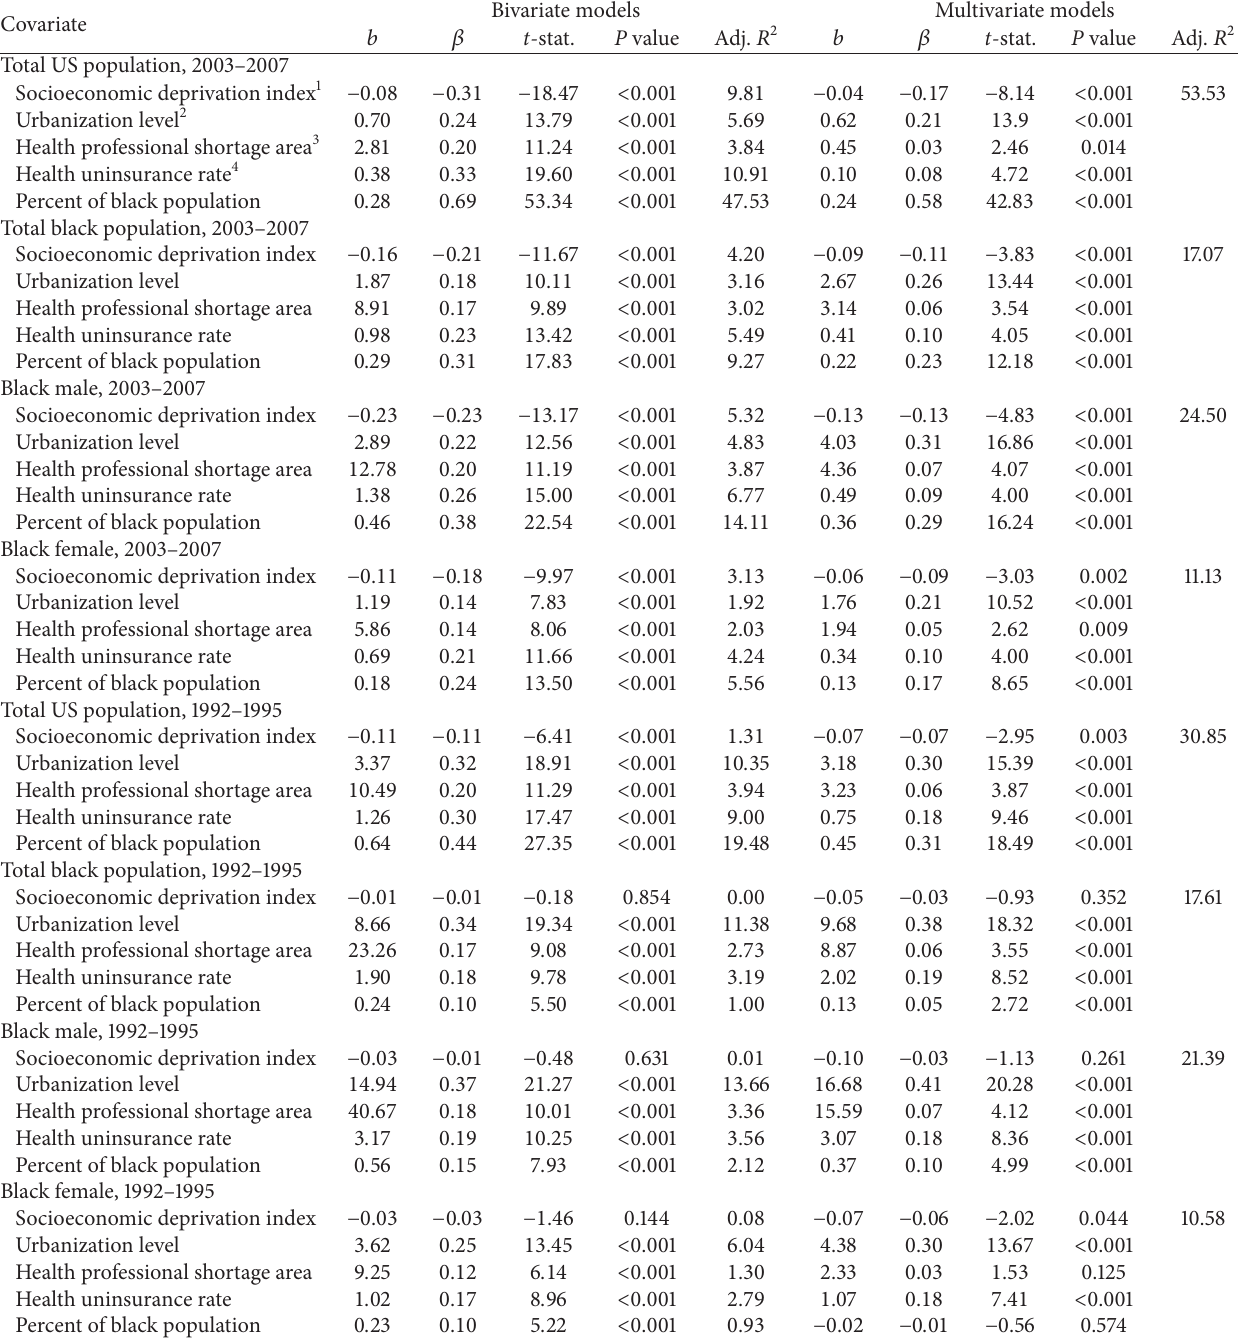
Table 2: Weighted least squares regression models showing the impacts of the continuous socioeconomic deprivation index, urbanization level, primary medical care shortage areas, health uninsurance rate, and racial composition on county-level age-adjusted HIV/AIDS mortality rates, United States, 1992–1995 and 2003–2007 ( N =